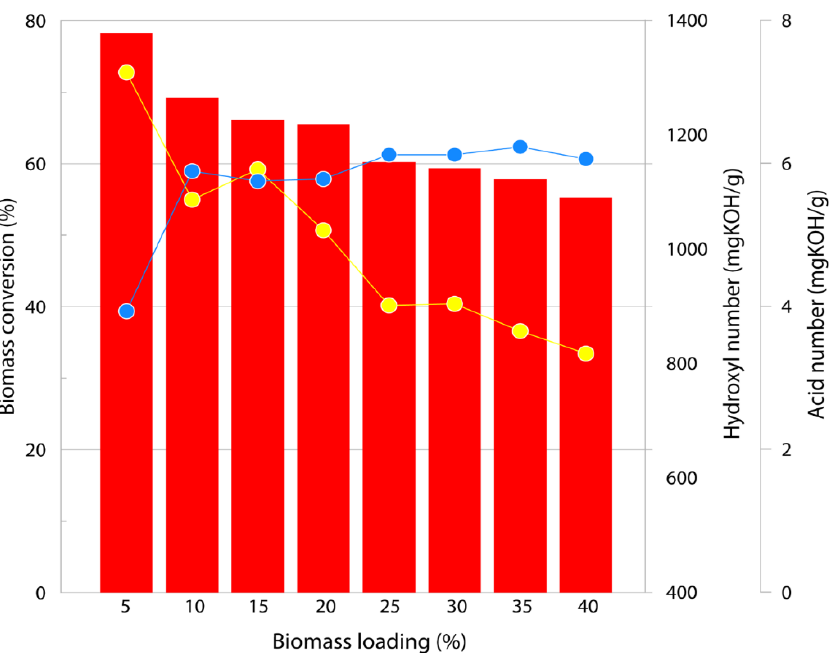
Figure 3. Effect of biomass loading on biomass conversion and biopolyol acid number (blue line) and hydroxyl number (yellow line). Reaction condition: solvent blending ratio, 1:2; temperature, 120 °C; catalyst loading, 1%; reaction time, 10 min.